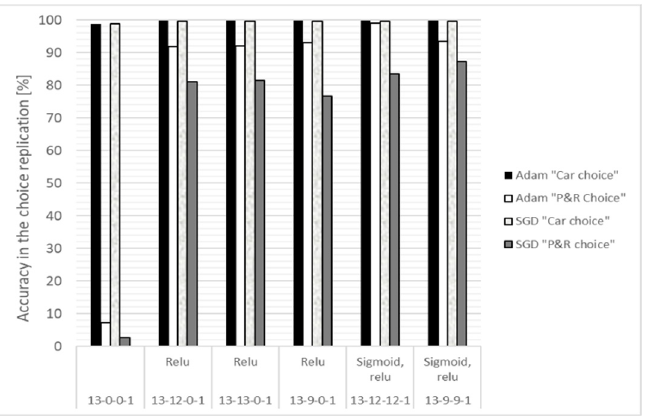
Figure 6. Results of different calibrated ANNs (disaggregated approach) for different activation function (Relu and Sigmoid, relu), numbers of hidden layers, and number of neurons in the hidden layers. If i – j are equal to zero, i.e., no hidden layers, a Perceptron network is obtained